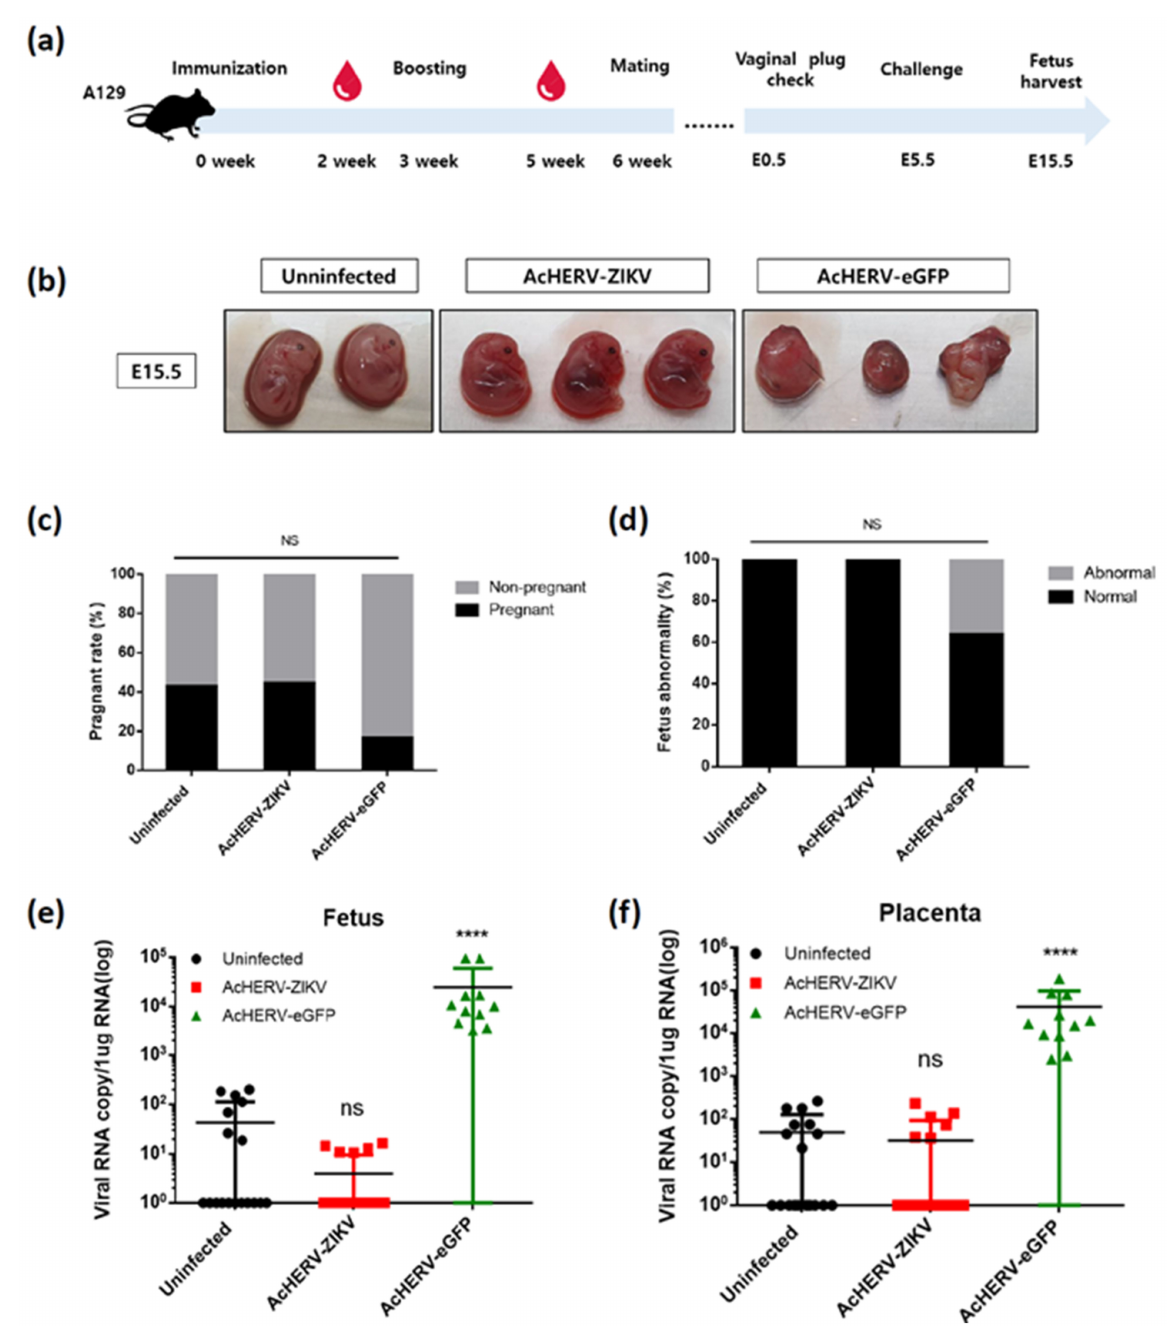
Figure 4. AcHERV-ZIKV protects against placental and fetal ZIKV infection. Female A129 mice (8 weeks old) were immunized with 5 × 10 7 FFU of AcHERV-ZIKV by intramuscular injection. An AcHERV-eGFP-immunized group was used as a negative control. After 3 weeks, mice were boosted with an equivalent dose of same recombinant baculovirus. Mouse sera were collected at 2 weeks post-immunization. After the presence of a vaginal plug was determined, mice were inoculated with 1 × 10 4 PFU of ZIKV FLR strain by intraperitoneal injection. ( a ) Schematic illustration of vaccination and virus challenge procedures performed using A129 mice. ( b ) Left panel, normal E15.5 fetuses from uninfected dams. Middle panel, representative images of E15.5 fetuses from AcHERV-ZIKV-vaccinated dams. Right panel, representative images of grossly hylomorphic E15.5 fetuses from AcHERV-eGFP-immunized dams. ( c ) The pregnancy rate in mated and plugged mice (ZIKV, n = 9; eGFP, n = 18; NTC, n = 7). ( d ) The percentage of fetal abnormality (ZIKV, n = 18; eGFP, n = 11; NTC, n = 15). ZIKV loads in the fetuses ( e ) and placentae ( f ) of pregnant mice. **** p < 0.0001; ns, not significant, compared with the placebo